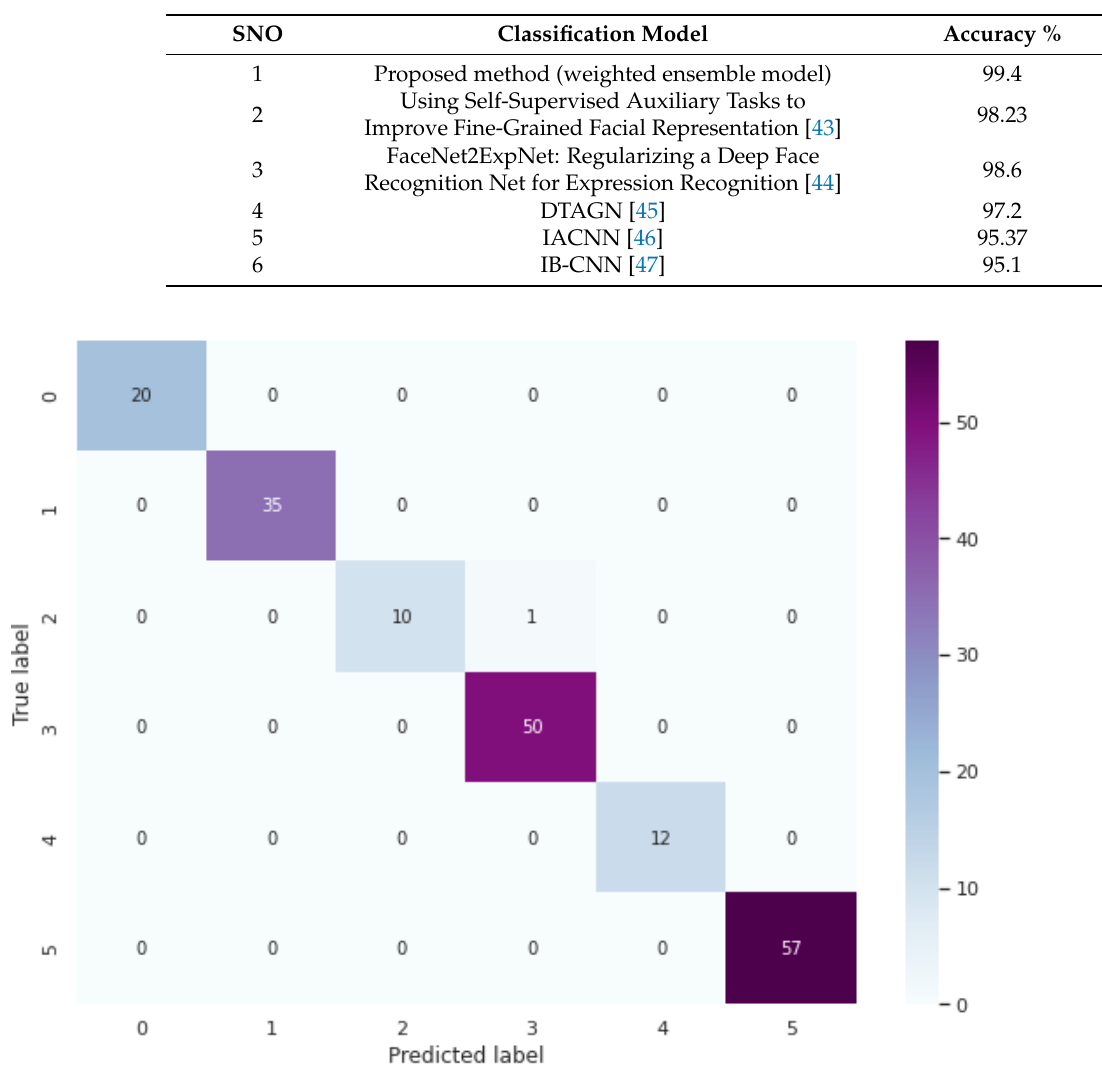
Figure 5. Confusion matrix on the CK+ dataset.